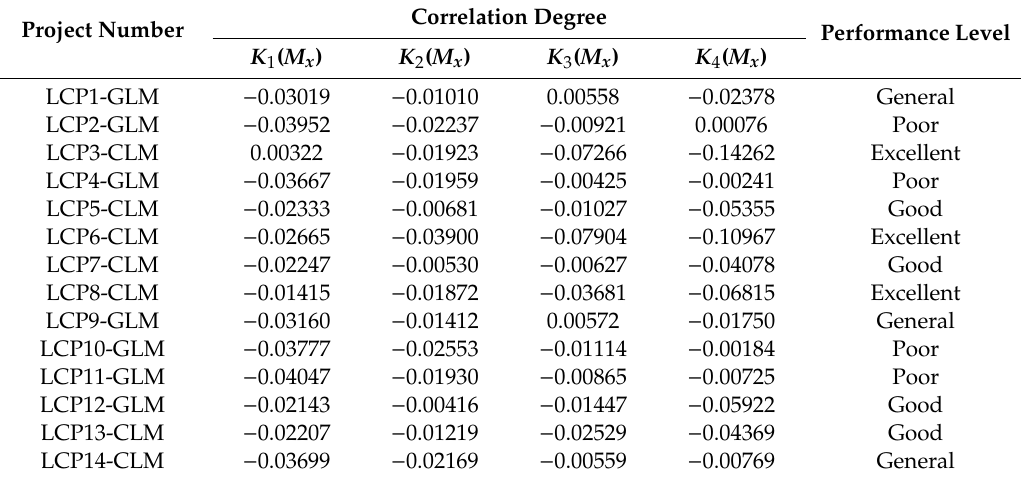
Table 5. Results of performance evaluation of 14 LCPs in Jianghan Plain of Hubei